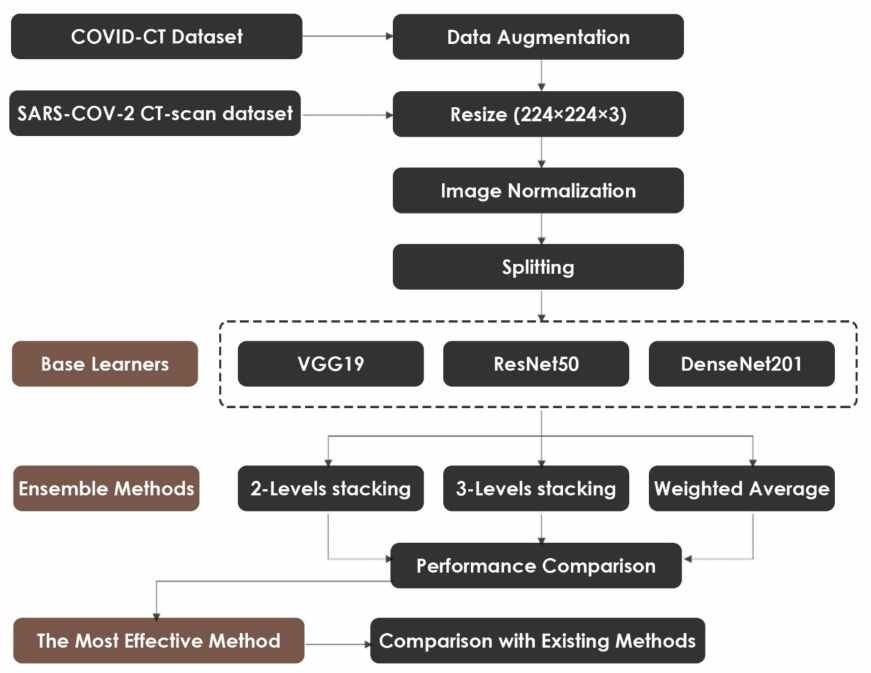
Figure 1. Flowchart of the Ensemble Learning